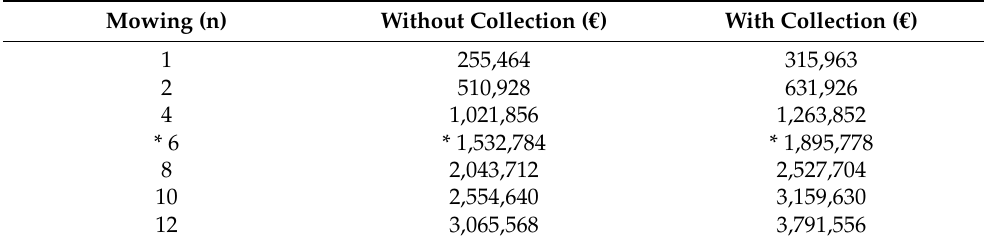
Table 6. Range of variation of the annual economic requirements based on the number of mowing on all mapped green areas with and without grass collection. The ideal number of cutting grass operation is marked with (*), and it is equal to 6